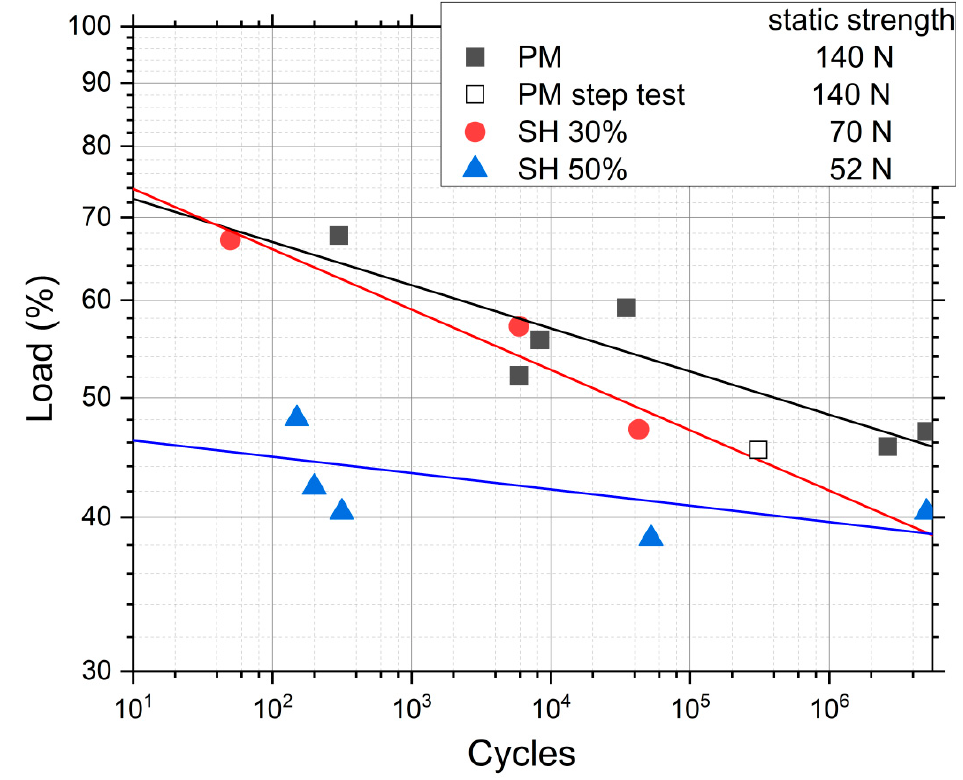
Figure 3. Results of the conventional fatigue tests for implants with different porosities, and the result of one test with the procedure of the step fatigue test. The load percentage is with respect to the static strength. Table 3. Step fatigue tests of porous dental implants (PM and SH 30 vol.%).